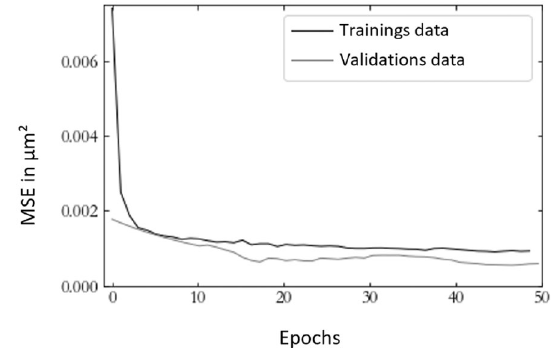
Fig. 2 Learning curve of the trained model